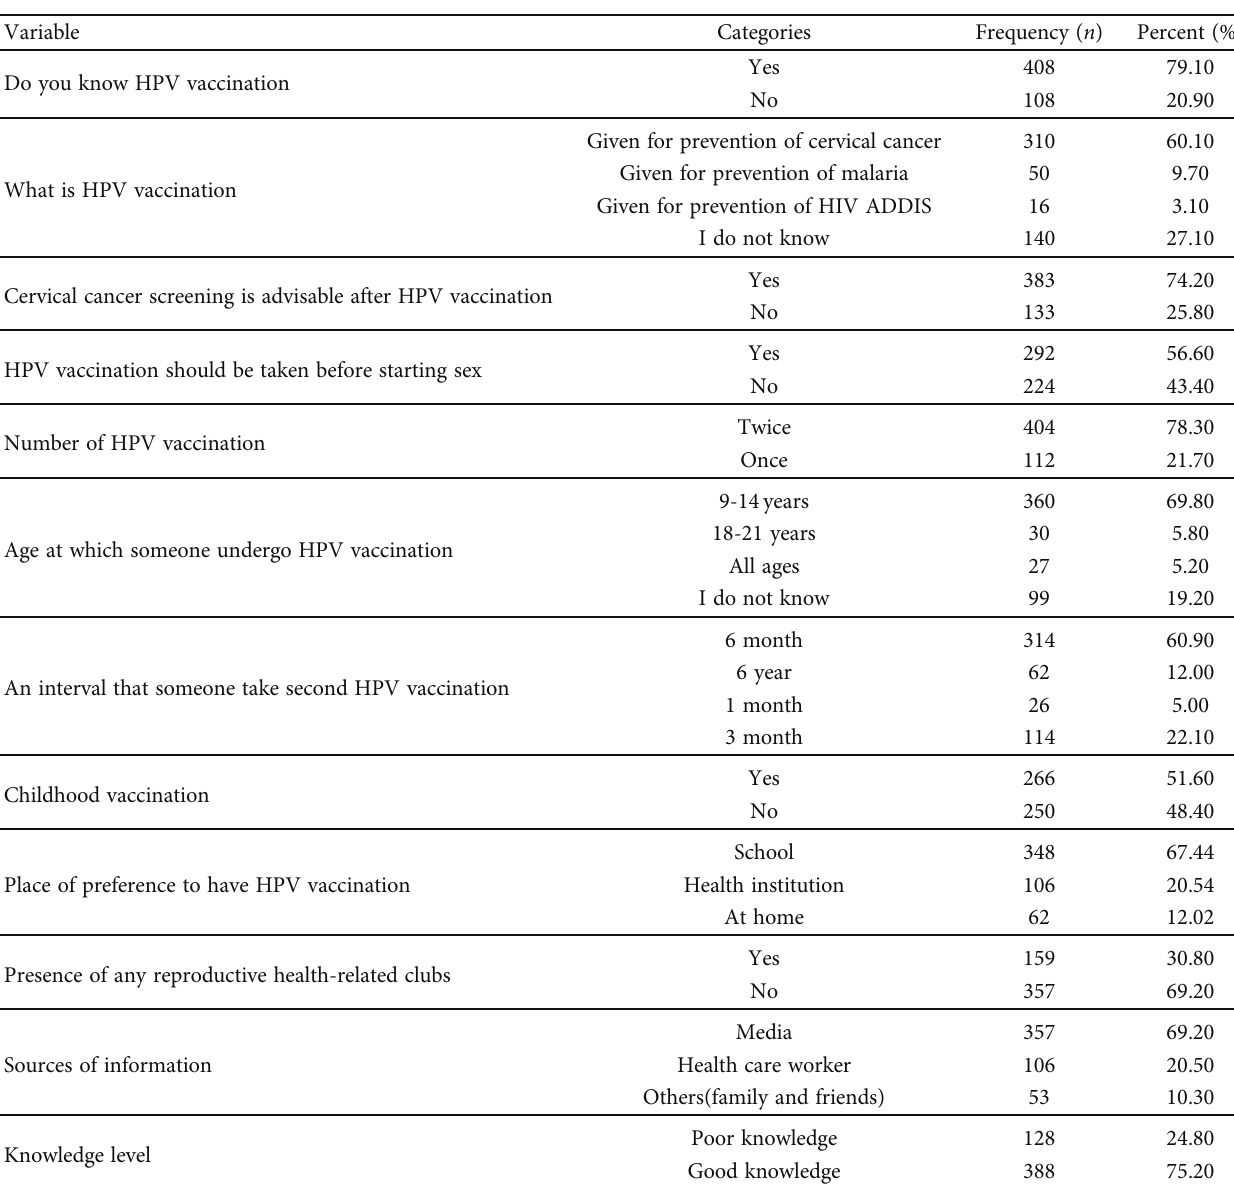
Table 2: Knowledge of girl students about HPV vaccination and related responses in Arba Minch town, Southern Ethiopia, 2020.